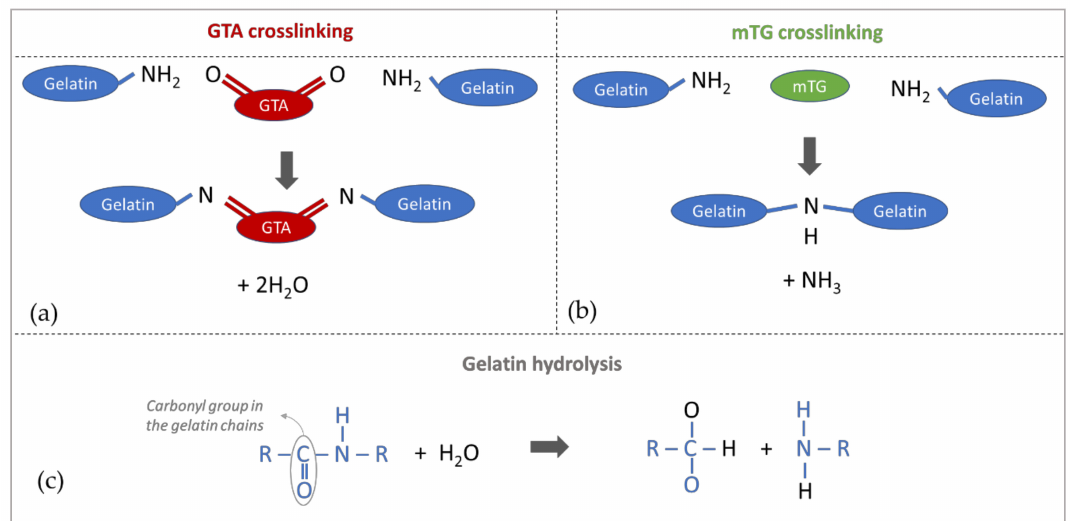
Figure 5. Schematic of gelatin crosslinking with ( a ) glutaraldehyde (GTA) and ( b ) microbial transglutaminase (mTG); ( c ) Schematic of gelatin hydrolysis